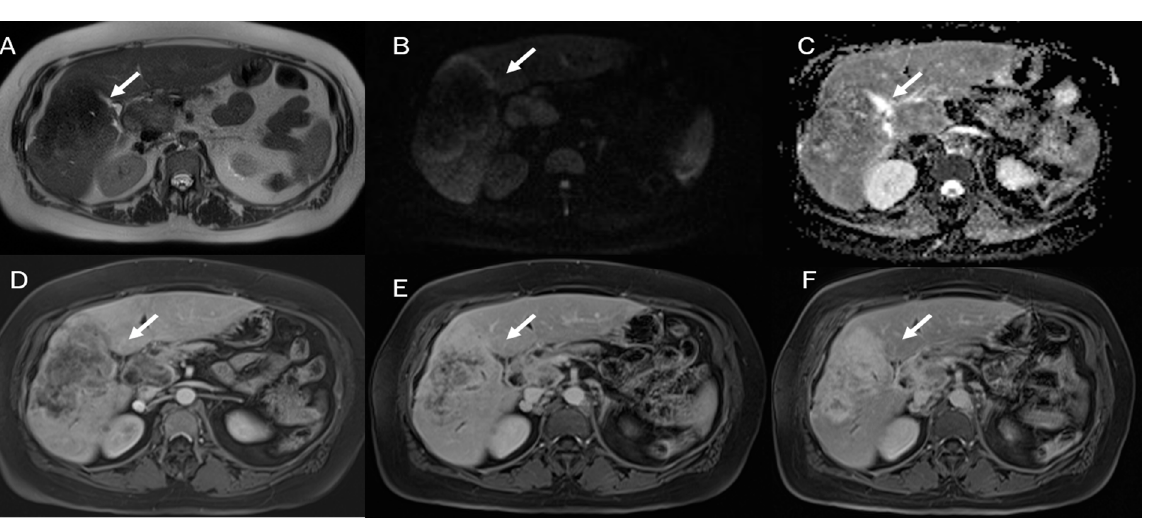
Figure 6. MRI assessment of periductal-infiltrating CCA. The lesion (arrow) shows hyperintense signal in T2-W ( A ), causing biliary tree dilatation in cholangiography sequences ( B ). During arterial phase ( C ), the lesion causes hyperenhancement of surrounding liver parenchymal, showing a pro- gressive contrast enhancement in portal phase ( D ). A hepatocyte-specific contrast agent, gadolinium ethoxybenzyl diethylenetriamine pentaacetic acid (Gd-EOB-DTPA), enhances the blood pool and is hepatocyte specific, since it is taken up by hepatocytes and excreted into the biliary tract (EOB phase). Ap- proximately 50% of the administered dose of Gd-EOB-DTPA is taken up by normal hepatocytes and subsequently excreted into the biliary tract, while the remaining 50% is